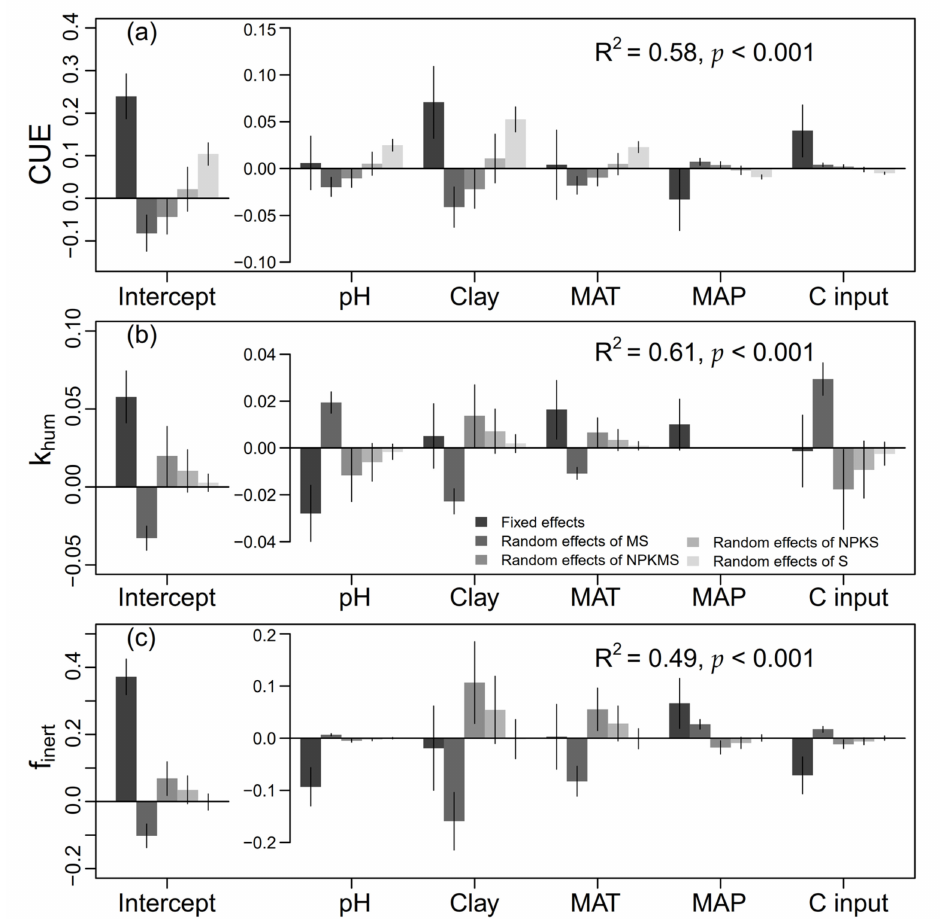
Figure 6. Coefficients of the fitted linear mixed model for predictions of the constrained median CUE ( a ), k hum ( b ), and f inert ( c ). Intercept, the intercept of the linear mixed regression model; pH, soil pH; Clay, soil clay content; MAT, mean annual temperature; MAP, mean annual precipitation; Input C, the average annual C input rate. Error bars show the standard errors. R 2 is the coefficient of determination and p shows the associated significance